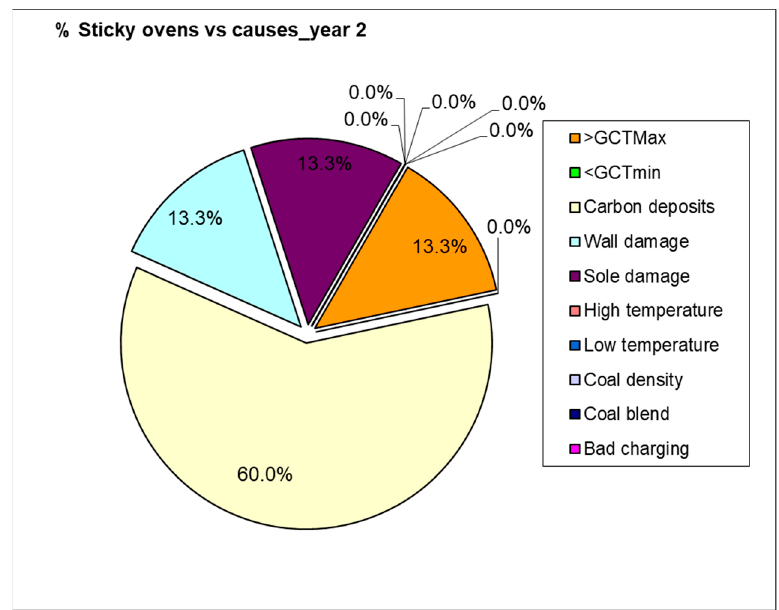
Figure 6. Causes of sticky ovens in the first year.